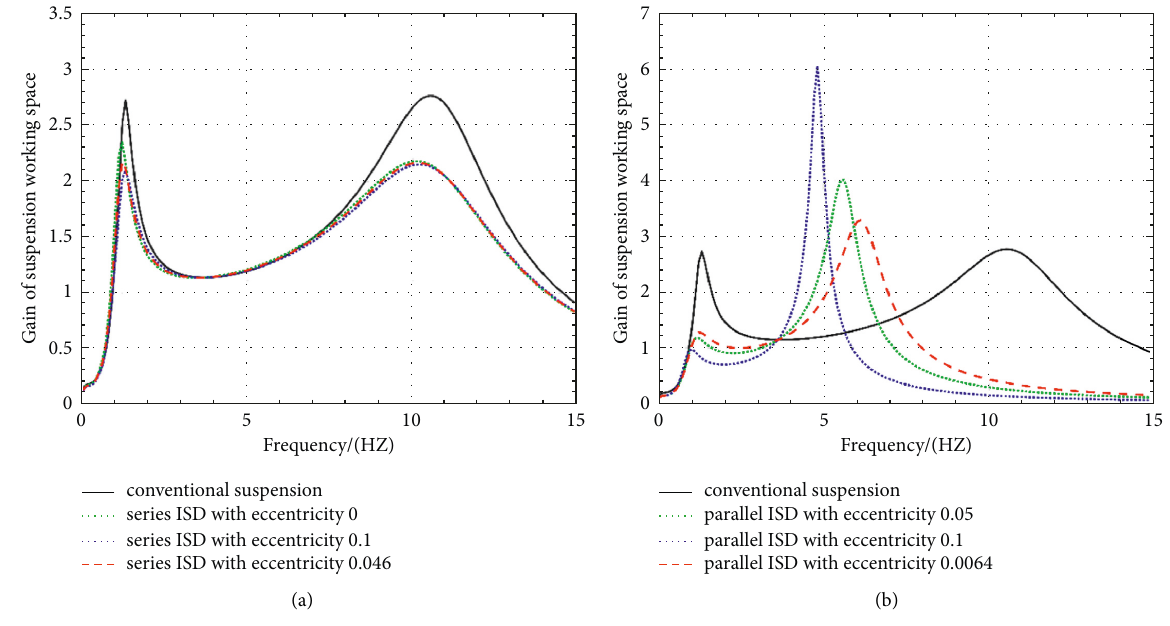
Figure 8: Responses of suspension working space in frequency